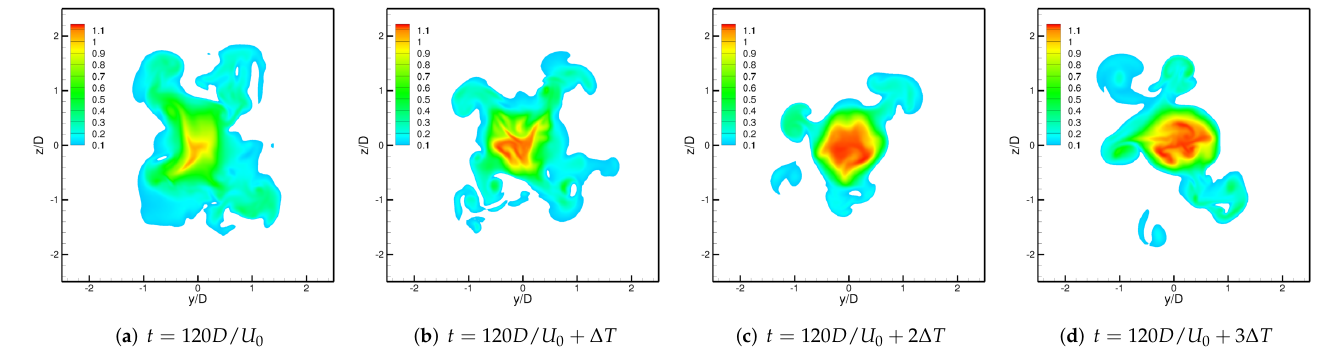
Figure 13. Contours of an instantaneous axial velocity U x / U 0 at the plane perpendicular to the jet axis x / D = 9 for the case E − Car − Ti 0.1